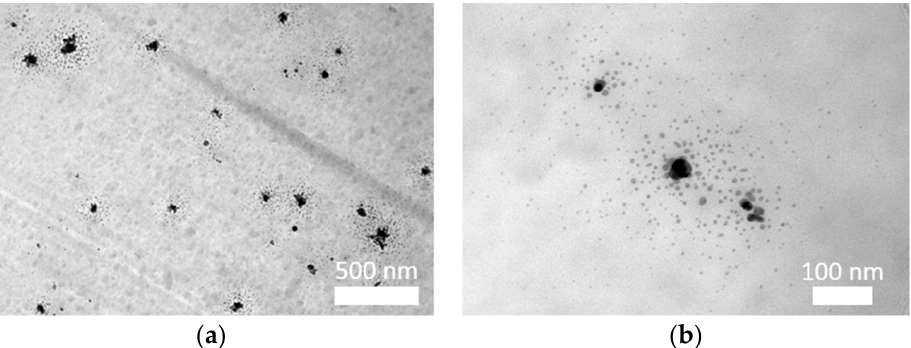
Figure 5. HRTEM images of the distribution of nanoparticles in PAN fi bers: ( a ) cross-section; ( b ) longitudinal section.